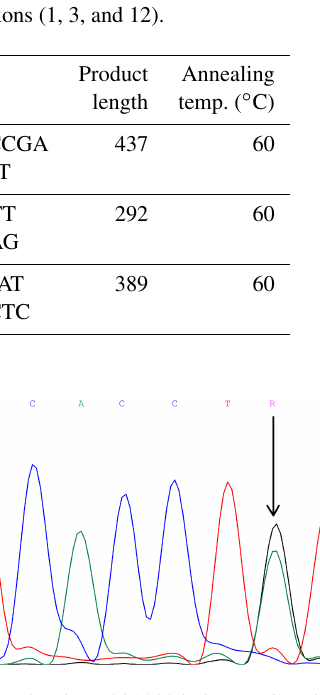
Figure 1. The rs209202414 A-to-G polymorphism in intron 3 of the bovine FADS2 gene revealed by DNA sequencing. Table 2. Genotypic frequencies of the rs209202414 SNP in the bovine FADS2